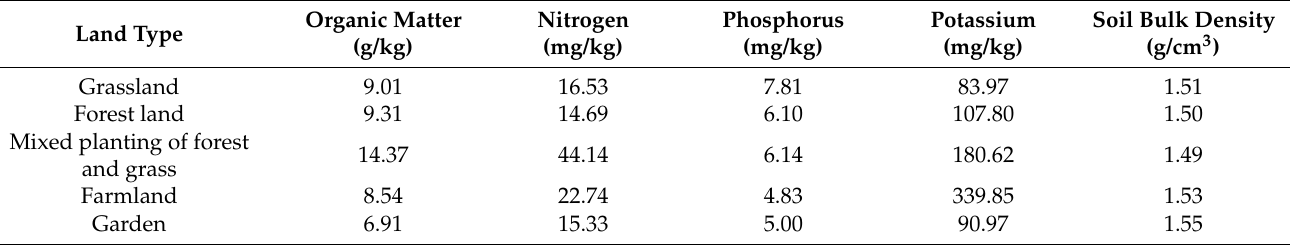
Table 5. The soil physical and chemical properties of different land